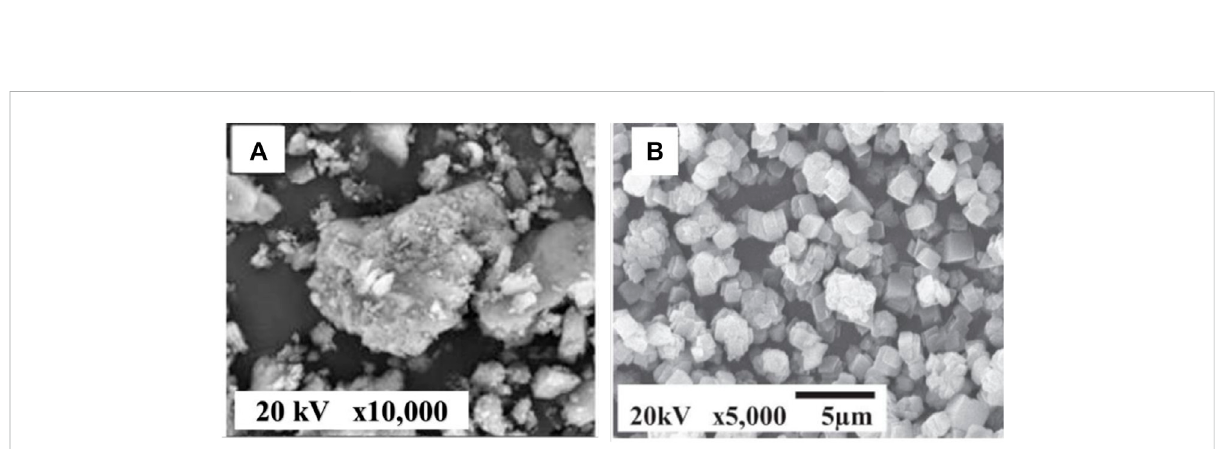
FIGURE 8 SEM microimages of (A) untreated calcite eggshell powders. Reproduce from Madiabu et al. (2021) “ Equilibrium and Kinetic Study of Removal Copper(II)fromAqueousSolutionUsingChickenEggshells:LowCostSorbent ” https://ojs.jmolekul.com/ojs/index.php/jm/article/view/658licensed under CC BY 4.0. (B) Precipitated calcite eggshell powders. Reproduced with permission from Putkham et al.